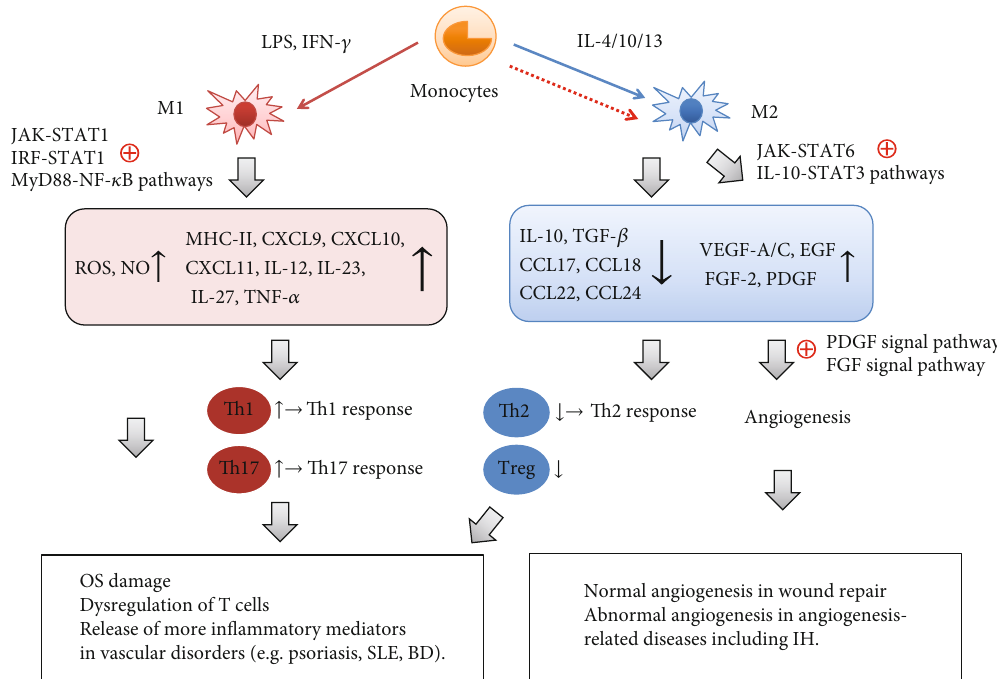
Figure 2: Possible mechanisms of di ff erent macrophage polarizations in vascular disorders. Upon the di ff erent stimuli, monocytes tend to di ff erentiate into M1 or M2 macrophages via di ff erent signaling pathways. In most vascular in fl ammatory diseases, M1 activation is dominant, whereas M2 activation is relatively inhibited. Through activation of the pathways (JAK/STAT1, IRF/STAT1, and MyD88/NF- κ B), activated M1 macrophages release various in fl ammatory mediators, such as MHC-II, chemokines (CXCL10 and CXCL11), and in fl ammatory cytokines (TNF- α , IL-12, IL-23, and IL-27), to encourage the activation of Th1/Th17 cells and trigger Th1/Th17 response. Apart from that, M1 macrophages produce substantial ROS and NO. As the key factors that regulate the di ff erentiation and chemotaxis of Th2/Treg cells, however, M2-secreted chemokines (CCL17, CCL18, CCL22, and CCL24) and anti-in fl ammatory cytokines (TGF- β , IL-10) markedly decrease along with the inhibition of activated M2. As a result, these events may contribute to the appearance of T cell dysregulation, OS damage, and increased in fl ammatory mediators in the pathological process of vascular in fl ammatory disorders or dermatoses, e.g., psoriasis, SLE, and BD. On the other hand, activated M2 macrophages secrete abundant angiogenic factors (e.g., VEGF- A/C, FGF-2, EGF, and PDGF) via stimulating the JAK/STAT6 and IL-10/STAT3 pathways, which not only facilitate normal angiogenesis in wound repair but also promote abnormal angiogenesis in angiogenesis-related diseases including IH by activating the PDGF and FGF signal pathways. Notes: the red and blue solid arrows indicate normal activation, while the red dotted arrow indicates relative inactivation; ⊕ indicates “ activation, ” ↑ indicates “ upregulation, ” and ↓ indicates “ downregulation. ” Abbreviations: LPS: lipopolysaccharide; IFN- γ : interferon gamma; IL-4/10/13: interleukin 4/10/13; M1: classically activated macrophage; M2: alternatively activated macrophage; ROS: reactive oxygen species; NO: nitric oxide; MHC-II: major histocompatibility complex-II; CXCL9/10/11: chemokine (c-x-c motif) ligand 9/10/11; IL-10/12/23/27: interleukin 10/12/23/27; TNF- α : tumor necrosis factor alpha; CCL17/18/22/24: chemokine (c-c motif) ligand 17/18/22/24; VEGF-A/C: vascular endothelial growth factor A/C; EGF: epidermal growth factor; FGF-2: fi broblast growth factor 2; PDGF: platelet-derived growth factor; Th: T helper; Treg: regulatory T cells; OS: oxidative stress; SLE: systemic lupus erythematosus; BD: Behcet ’ s disease; IH: infantile